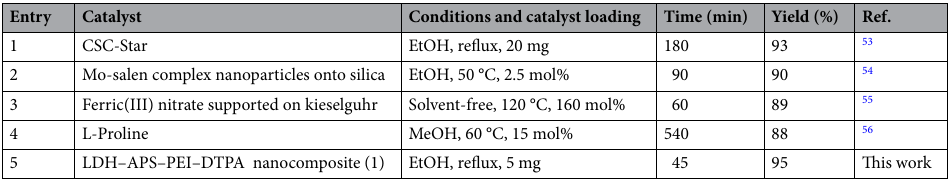
Table 3. Comparing the catalytic performance of the LDH–APS–PEI–DTPA nanocomposite ( 1 ) with the previously reported catalysts for the synthesis of imidazole